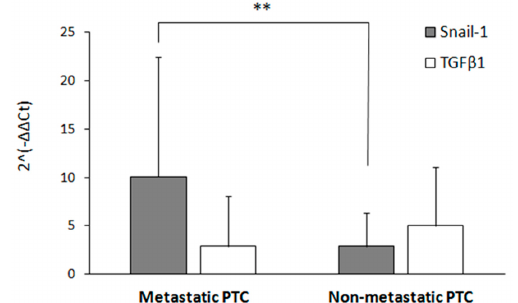
Figure 2. The expression of Snail-1 but not TGF β 1 was correlated with the metastatic phenotype in PTC samples. The gene expression was evaluated by quantitative RT-qPCR in metastatic ( n = 18) and non-metastatic ( n = 43) PTC groups. The relative mRNA level was normalized to GAPDH. The results are presented as the mean of three independent experiments ± SD. ** p < 0.001.